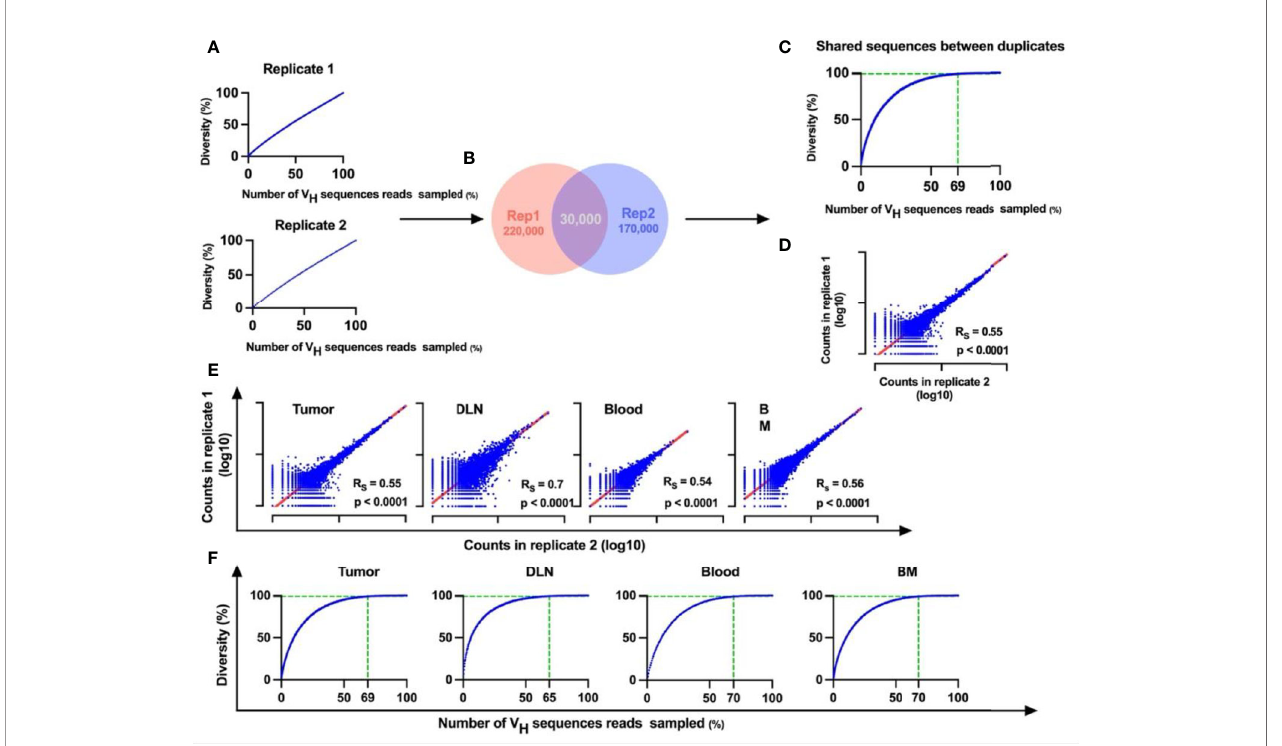
FIGURE 2 | Duplicate approach for removal of errors from BCR-Seq data. (A) Rarefaction curves for each duplicate originating from the same sample. X-axis represents the percent of sampled V H sequences reads in each iteration out of the total number of V H sequences reads in the sample, and Y-axis represents diversity of unique V H sequences that were sampled as a percent out of the total number of unique V H sequences (B) Venn diagram of the duplicates, showing an example of the number of unique V H sequences in each duplicate and the number of shared unique V H sequences between duplicates. (C) Rarefaction curve for the shared V H sequences as identi fi ed in both technical duplicates. The vertical dashed line indicates the percent of V H sequences reads in which unique V H sequence diversity reaches 99%. (D) Correlation between duplicates. Transcript counts for each V H sequence were correlated between duplicates. X and Y axes are on a logarithmic scale and represent the transcript counts for each sequence. Each sequence is represented by a blue dot. (E) Correlation between library duplicates from all tissues. (F) Rarefaction curves for sequences from all tissues. R s , Spearman rank-order coef fi cient; p-values are indicated. BM, bone marrow; DLN, draining lymph